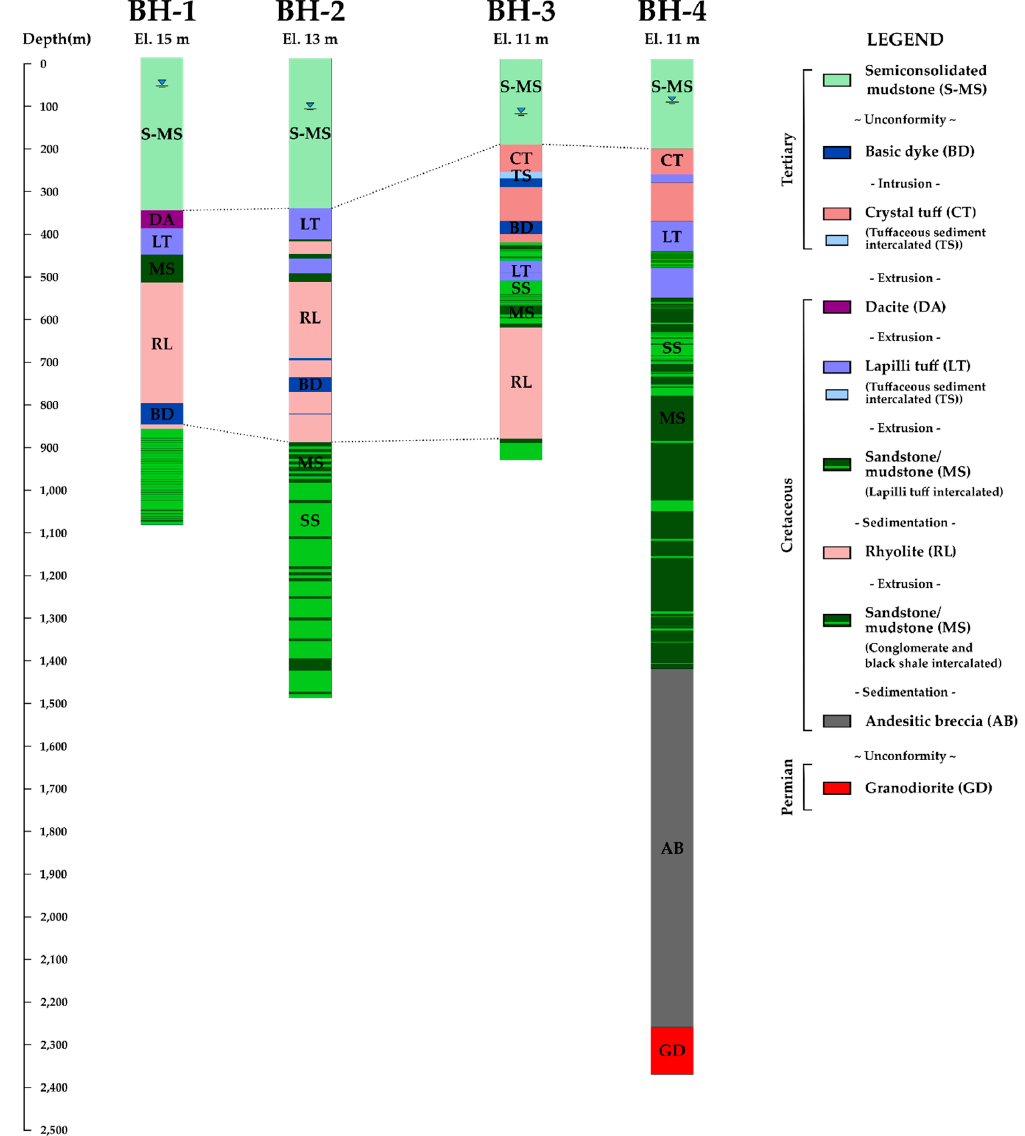
Figure 4. Lithological profiles from BH-1 to BH-4. The sandstone and rhyolite layers are connected by dotted lines between the boreholes.